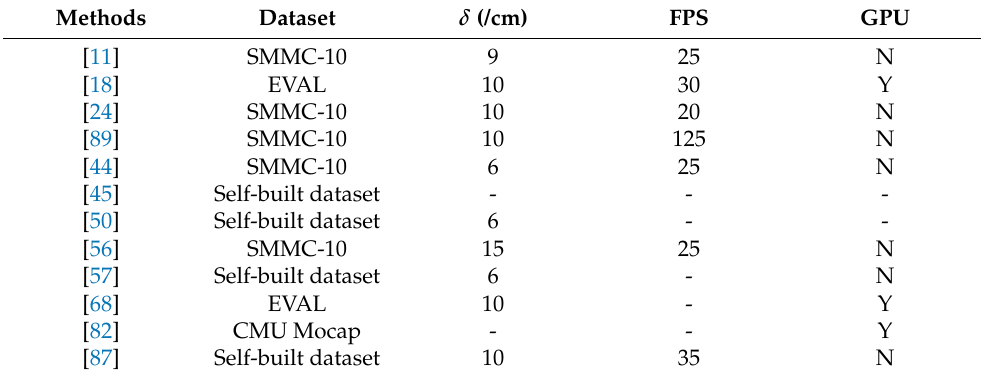
Table 2. Summary of the referenced works for human pose estimation with depth inputs.